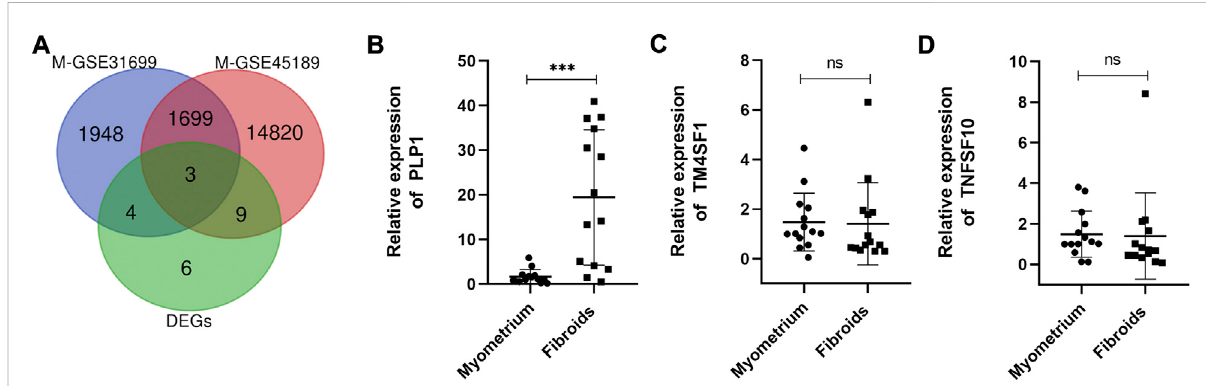
FIGURE 2 Identi fi cation of the hub gene. (A) The co-expressive differentially expressed genes in differently mRNA expression pro fi les (from GSE593, GSE31699, and GSE45189 datasets) and genome-wide DNA methylation genes (from GSE31699, GSE45189 datasets) by Venn diagram. M-GSE31699,M-GSE45189indicatedthedifferentialDNAmethylationgenes. (B – D) TherelativemRNAexpressionofTM4SF1,TNFSF10,andPLP1by RT-qPCR. n = 14/groups. *** p < 0.001. ns no statistical signi fi cance.